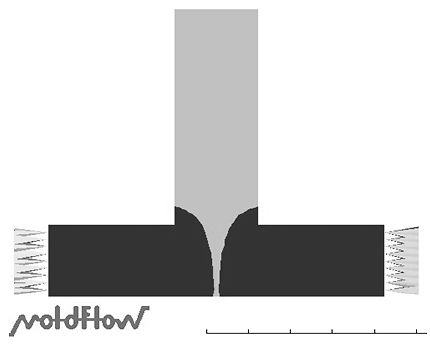
Figure 3. Simulation by commercial software MoldFlow®, front joining in mold cavity of shape K with opposite inlets.